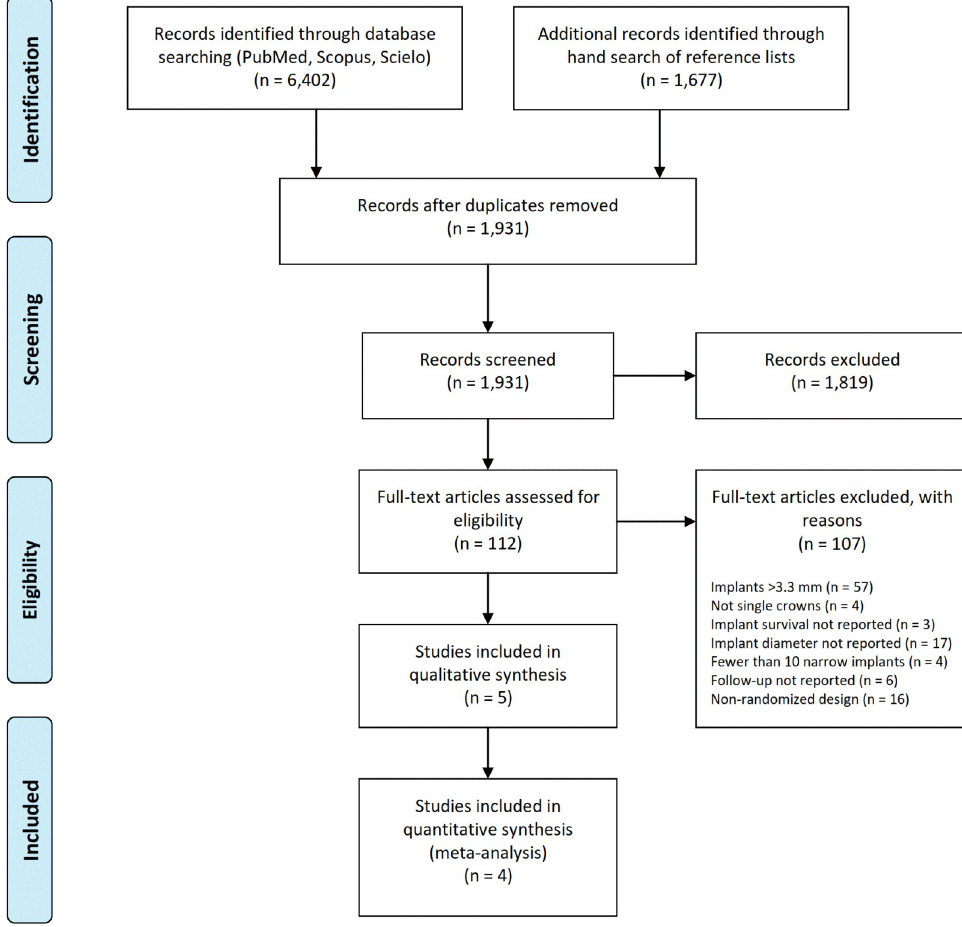
Fig 1. Flow diagram of study